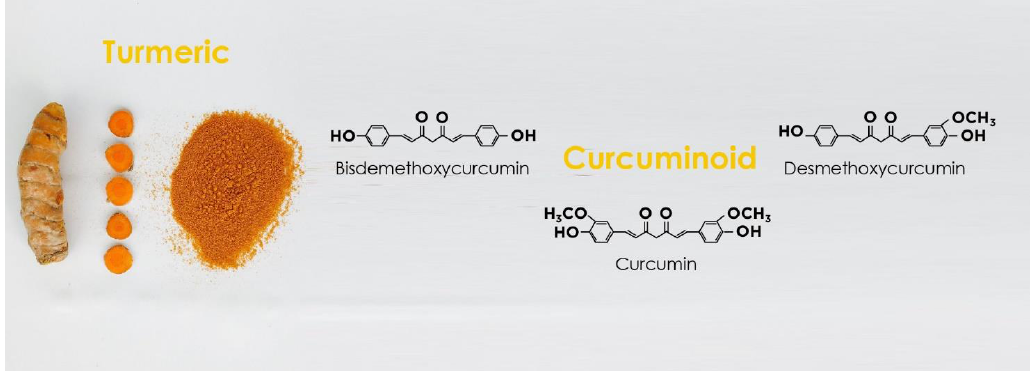
Figure 2. curcuminoids in turmeric and their chemical structures. Figure 2. Curcuminoids in turmeric and their chemical